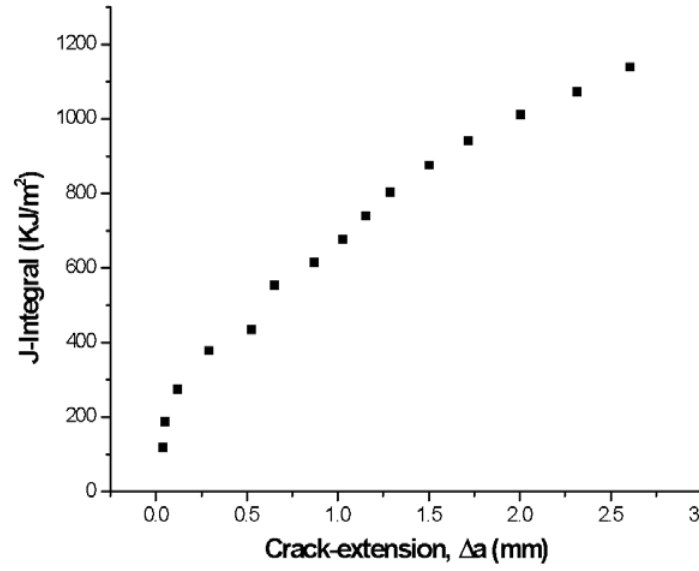
Figure 4: J-Integral vs. Crack-Extension